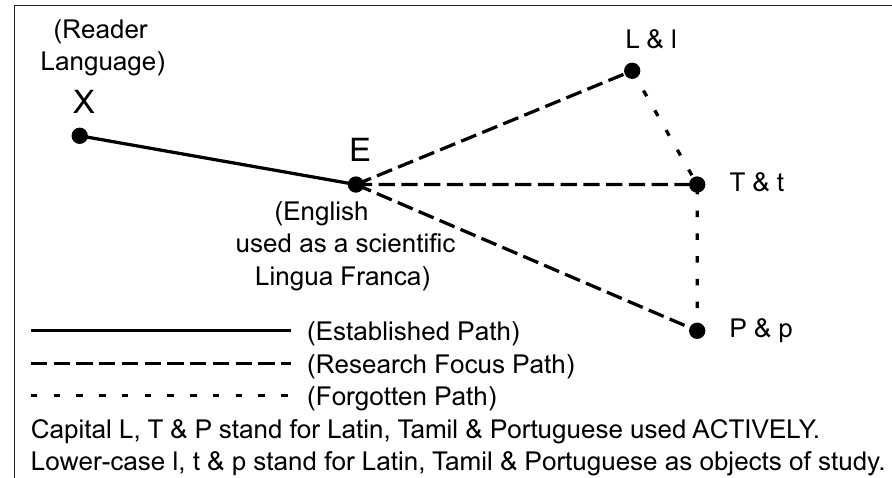
Figure 18: Knowledge is always mediated by at least one language, or by more … [There is no language-independant knowledge about languages] (A Battle Plan for future